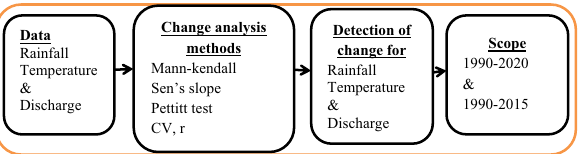
Fig. 2 Flow diagram to analyze changes of rainfall, temperature and